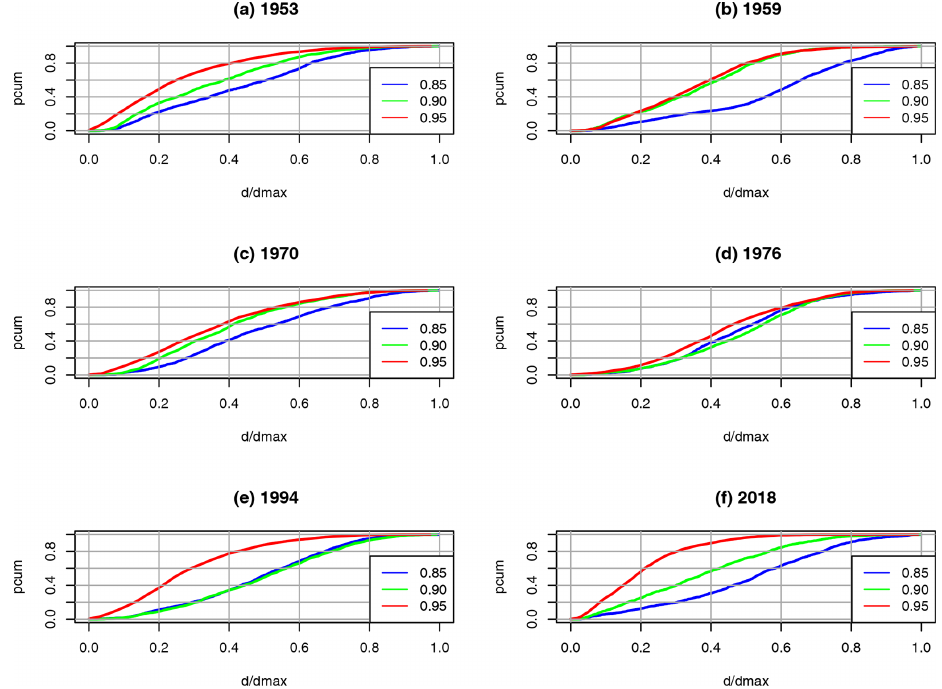
Figure 2. Drought in the GE region during the SHY, showing the dependence of the cumulative distribution p cum on the node degrees for 3 normal ( a, c, e – 1953, 1970 and 1994) and 3 extreme ( b, d, f – 1959, 1976 and 2018) years on the correlation threshold ρ 0 . Node degrees are normalised with maximum degree d max .